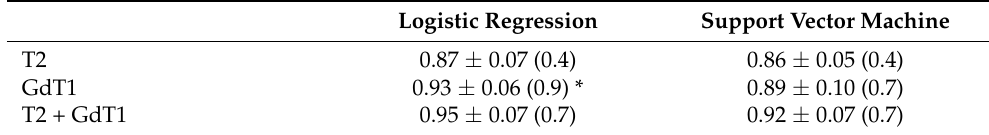
Table 3. AUC and diagnostic accuracy of machine learning models. Logistic Regression